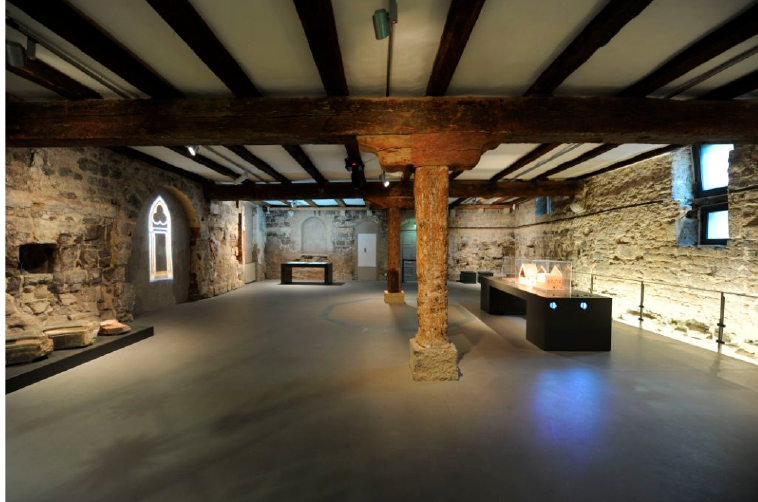
Figure 14. Ground Floor of the Museum (Albrecht von Kirchbach, used with permission).